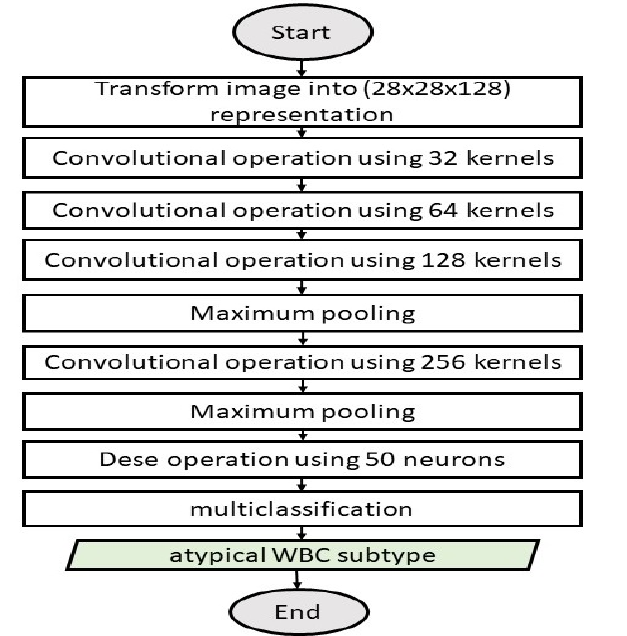
Figure 6. Stage II: Atypical WBC multiclassification